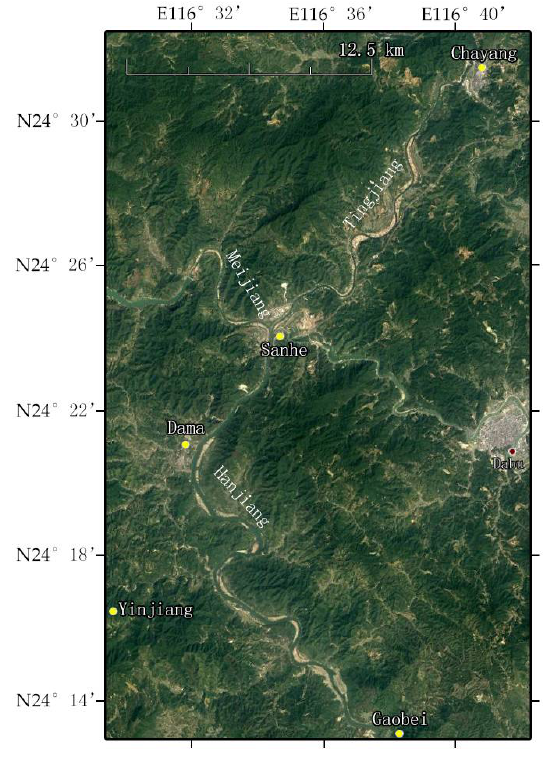
Figure 6. The schematic diagram of study area.